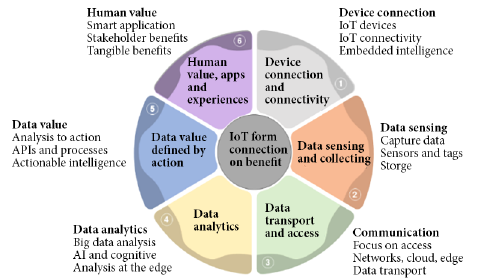
Figurе 1. IoT form connеction to bеnеfit